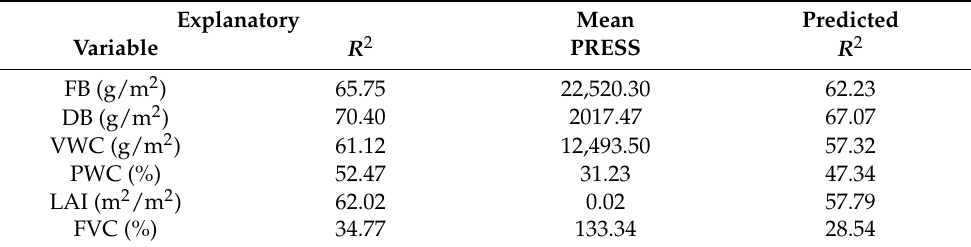
Table 4. Predictive capacity of the PLS analysis for each of the response variables of VBT, VT, VR, VO, PBT, PT, PR and PO associations for four components.